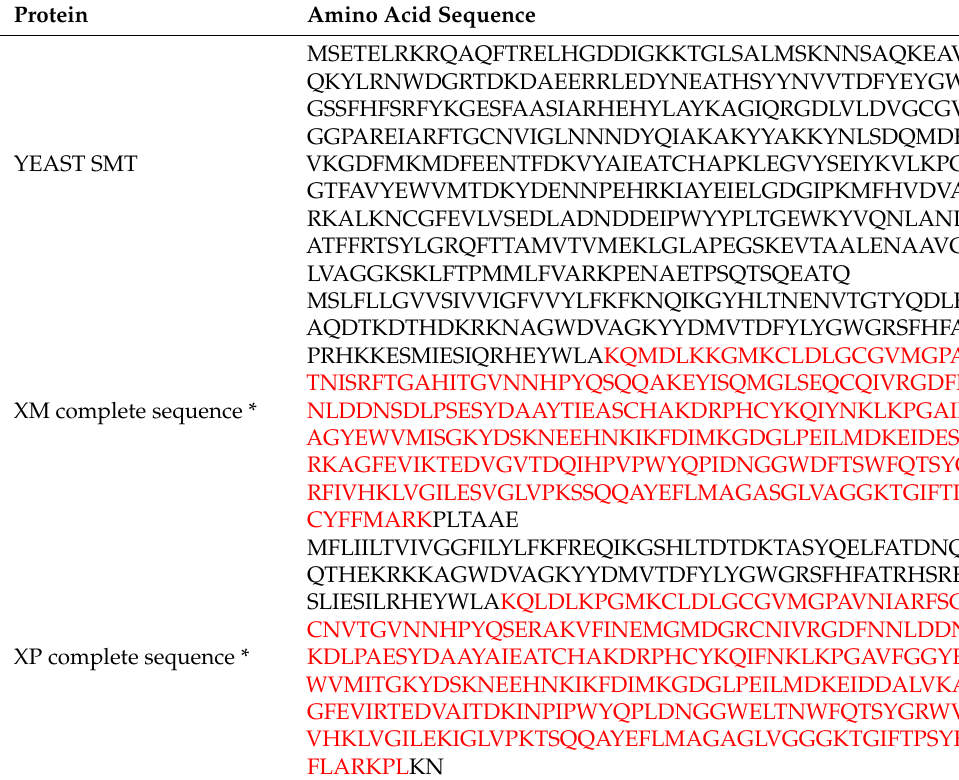
Table 5. Amino acid sequence for complete structure of Yeast SMT protein form